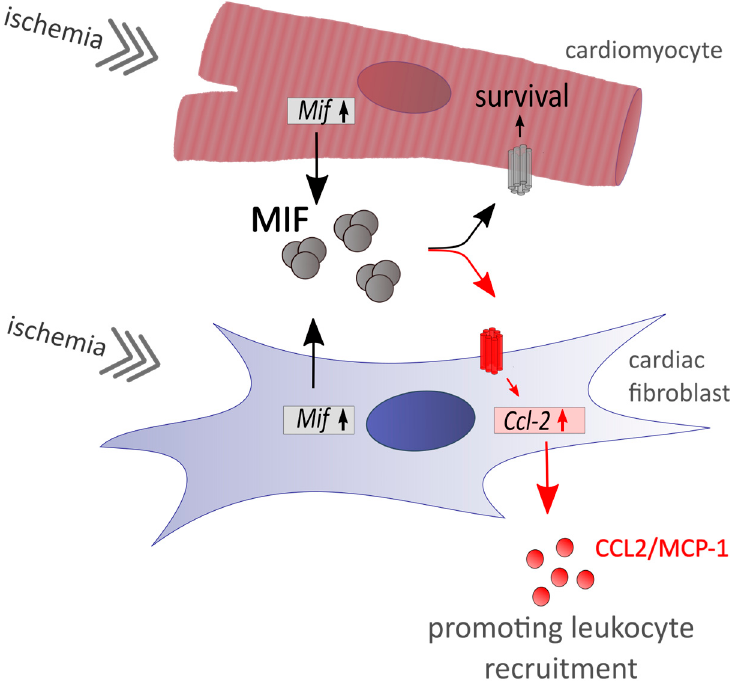
Figure 6. While ischemia induces Mif expression in both cardiac cell types, cardiomyocytes and cardiac fibroblasts, secreted MIF protein revealed different functions. Well characterized cardio-protective effects of MIF are only identified in cardiomyocytes, whereas cardiac fibroblasts may serve as sentinel cells to promote the pro-inflammatory effect of MIF by expressing chemoattractive chemokines.